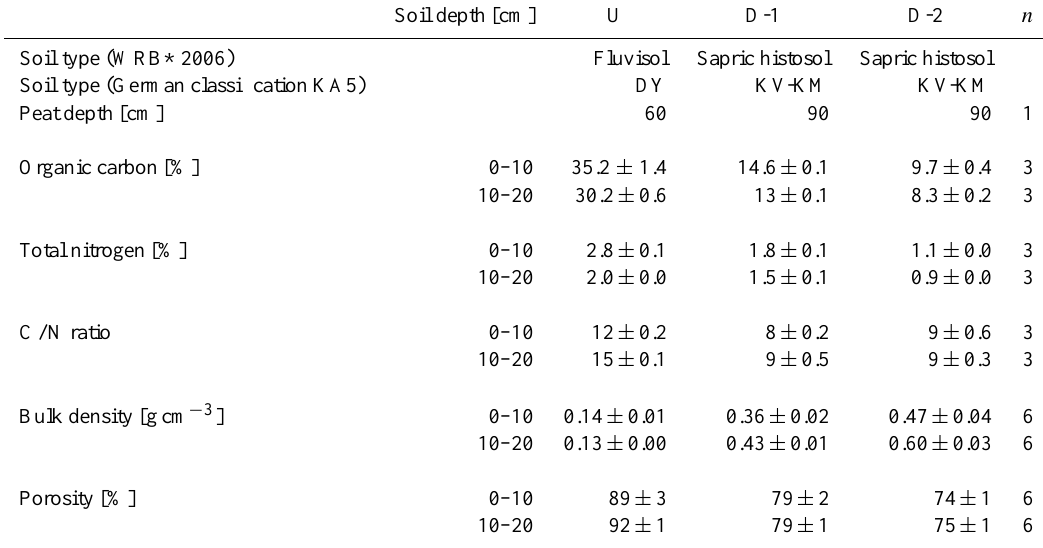
Table 2. Soil properties of the